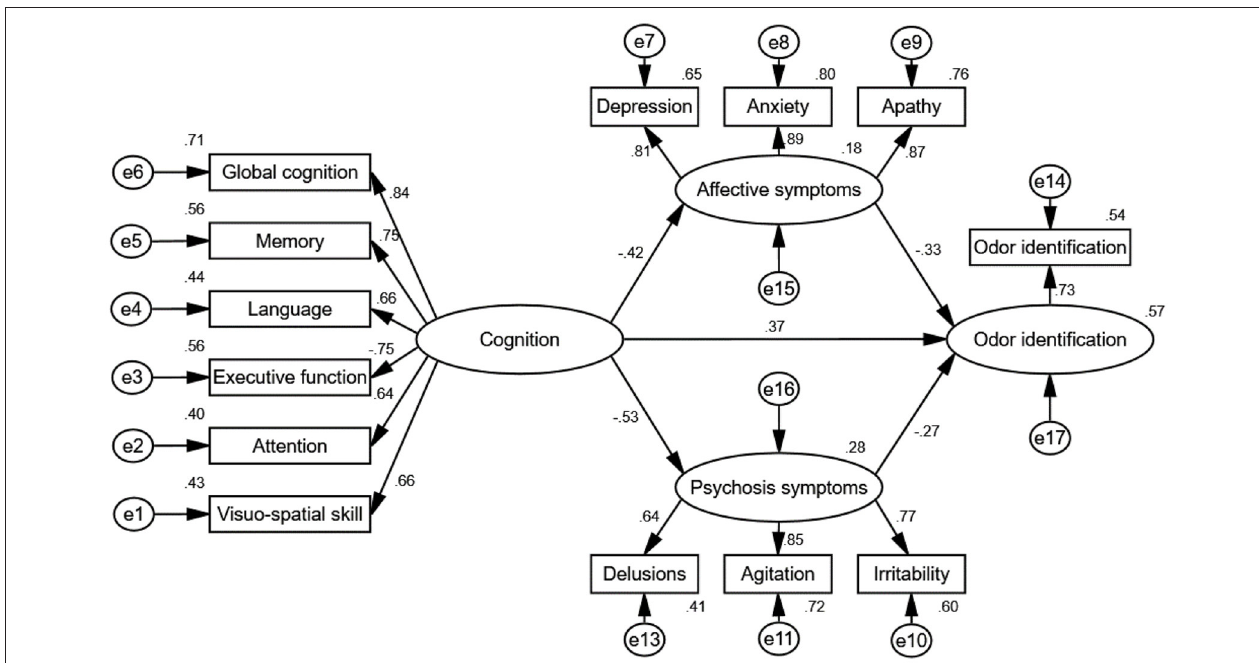
FIGURE 4 | Path diagram of the standardized estimate mediation model. The goodness-of-fit indices of the mediation model were χ 2 / df = 1.14, GFI = 0.99, CFI = 0.99, NFI = 0.94, IFI = 0.99, and RMSEA = 0.03, indicating a good fit. The mediation model shows that cognition had special indirect effects on odor identification through affective and psychosis symptoms, indicating that affective and psychosis symptoms exhibited partial mediated effects. Rotation converged in 9 iterations. e1–17 represent residuals of the respective